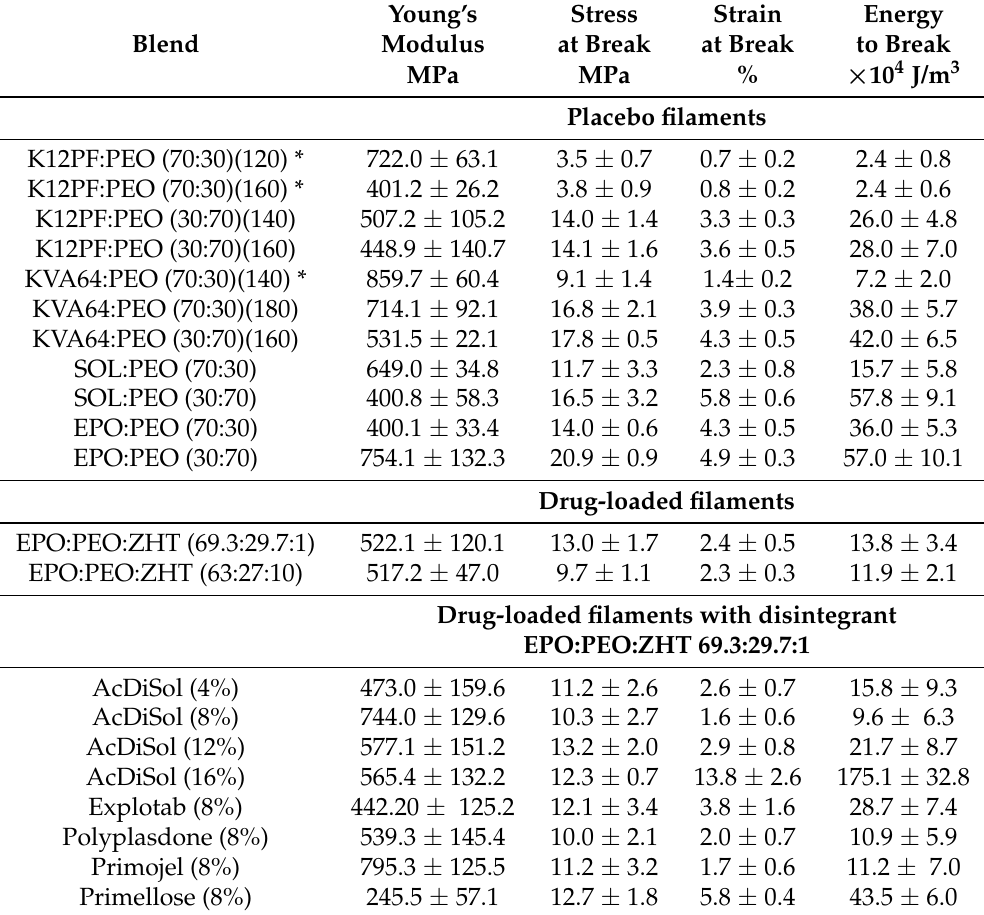
Table 2. Mechanical properties of all filaments analysed: Young’s modulus (EY), stress and strain at breaking point and tensile energy to break. Non-printable filaments are indicated with an asterix (*).